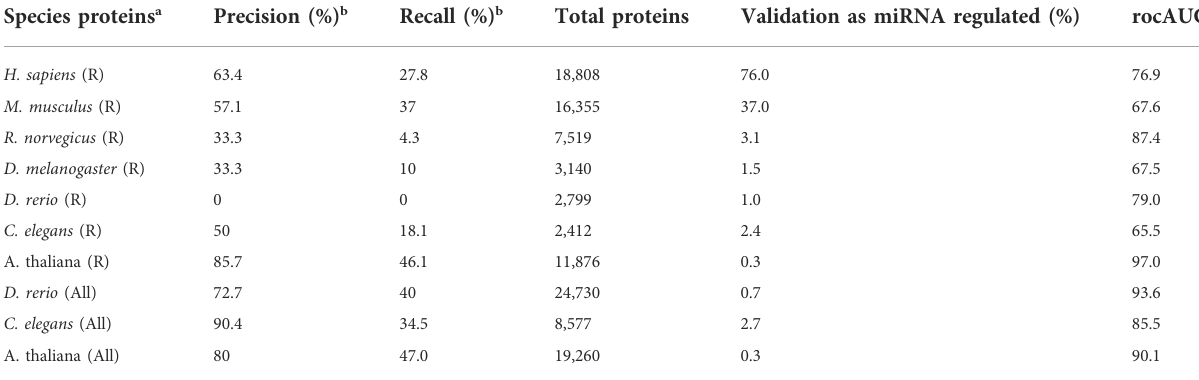
TABLE 1 miRNA predictions per organisms.